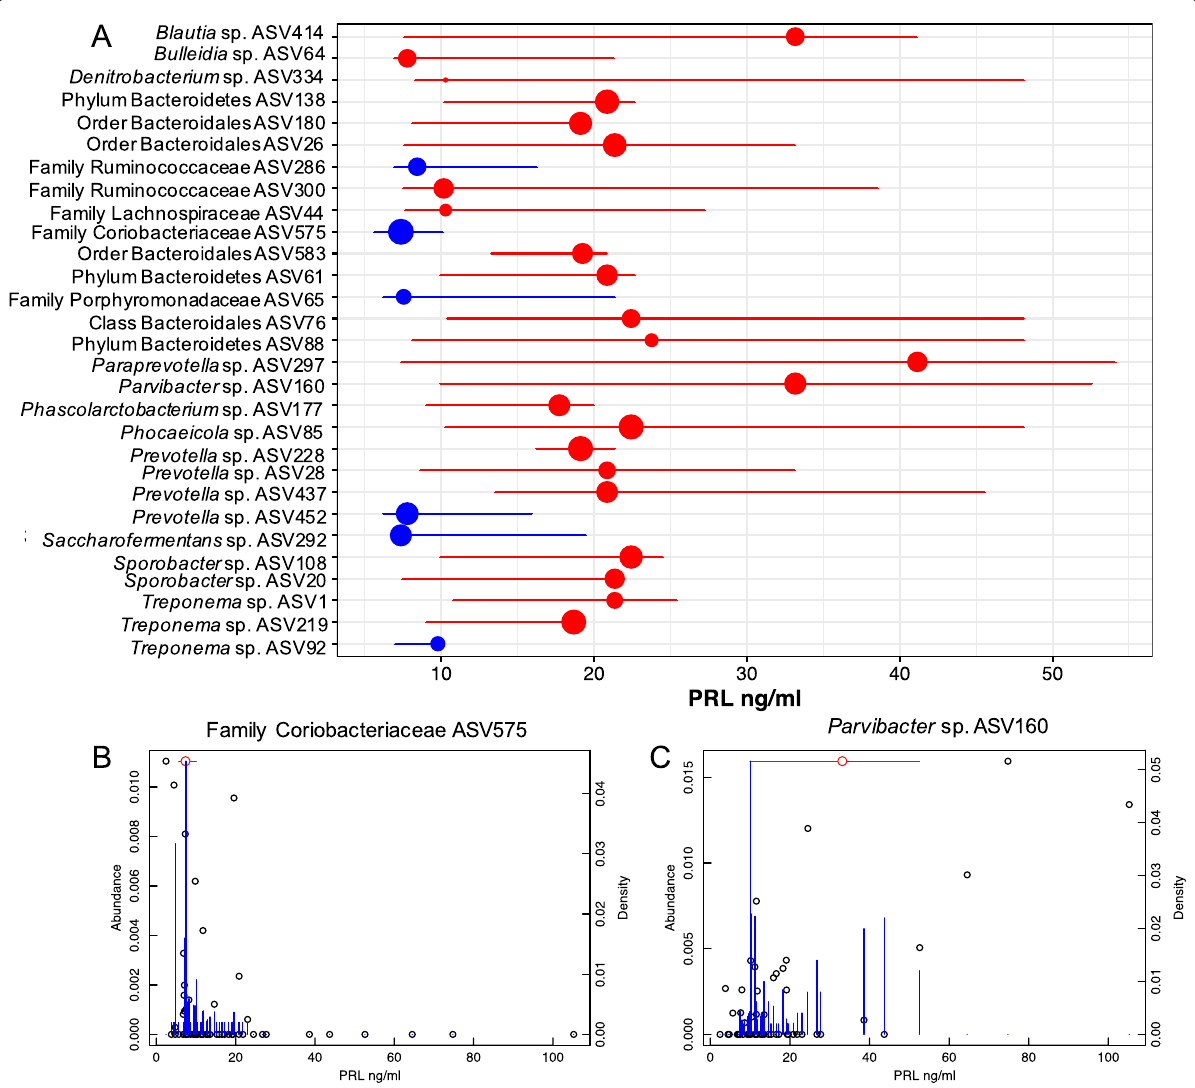
Fig. 5 Threshold Indicator Taxa Analysis (TITAN) for bacterial taxa in response to prolactin concentrations. A We identified bacterial changepoints in association with prolactin (PRL) concentrations, with a collective positive changepoint identified at 17.7 ng/ml. Circles represent bacterial taxa changepoints with red circles representing a positive response to prolactin (z The size of the circle reflects the magnitude of the Indicator Species Analysis statistic for the bacterial ASV. Horizontal lines represent the 5th and 95th percentiles among 500 bootstrap replicates. Examples of bacterial taxon abundance and density with a B negative response and C positive response to increasing prolactin concentrations. Blue lines represent bootstrap replicates for identifying change point. Red line indicates change